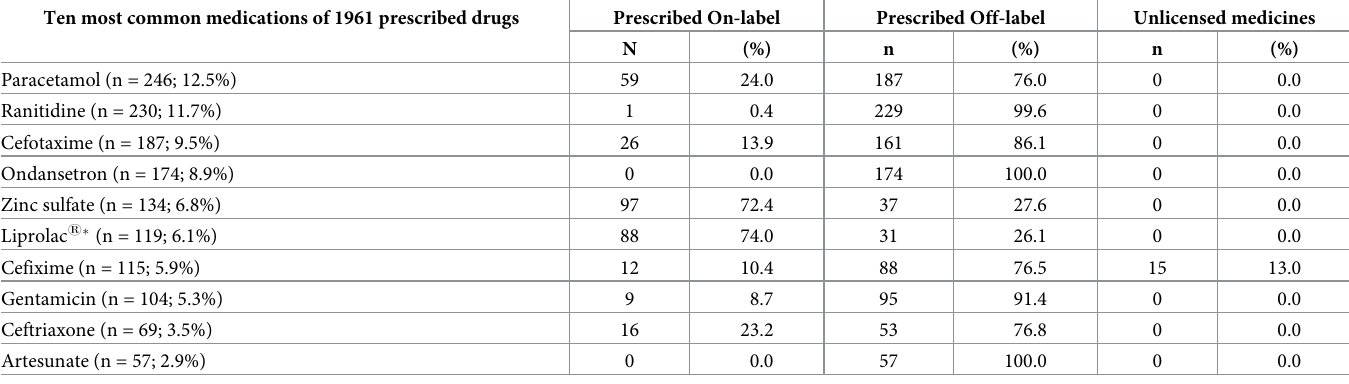
Table 1. The 10 most commonly prescribed drugs with their off-label and unlicensed status. The numbers in the columns are the number of prescriptions of the drug and the percentage of these which are on/off-label or unlicensed. Ten most common medications of 1961 prescribed